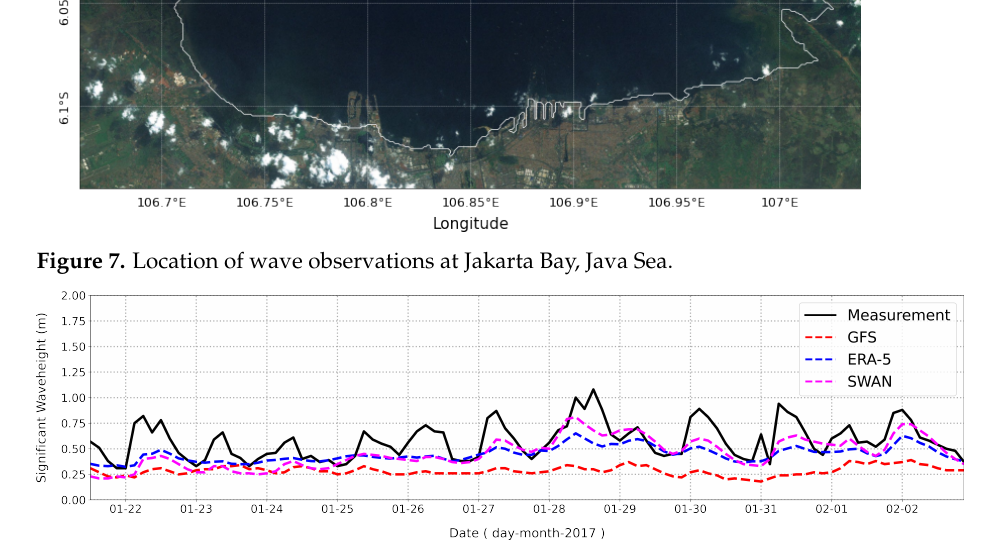
Figure 8. Comparison between the significant wave height results from the SWAN simulation with wave observation data, waves from ECMWF ERA-5, and waves from GFS-NOAA, in Jakarta